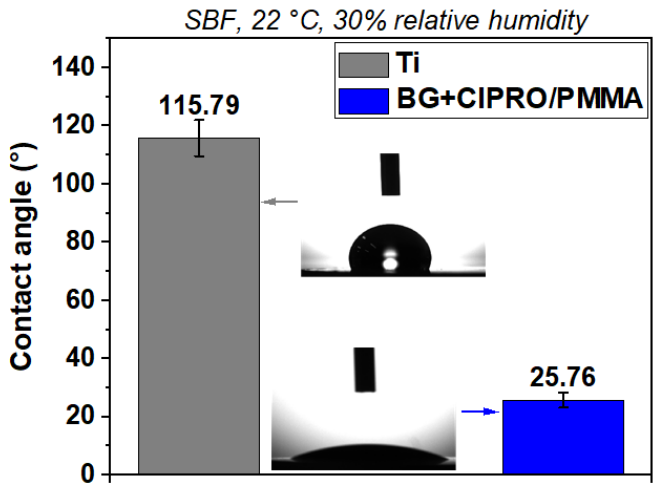
Figure 5. SBF CA measurements on bare Ti and Ti substrate coated with BG+CIPRO/PMMA .